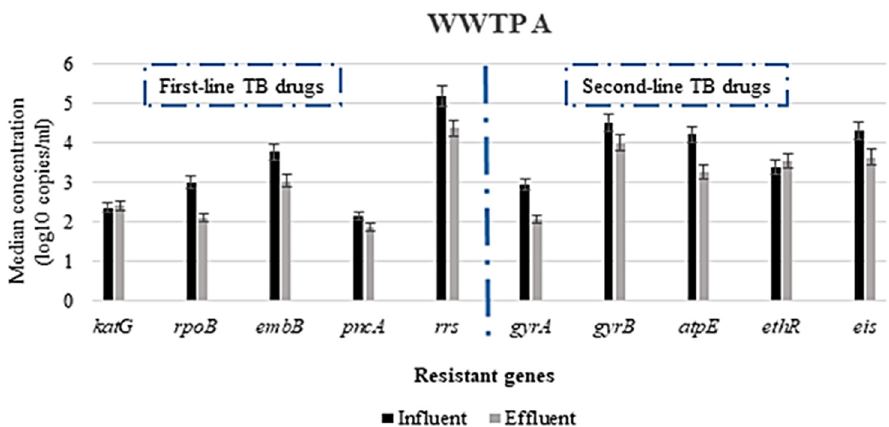
Figure 1. Median log copies/mL concentration of selected antimicrobial resistance genes in WWTP A.